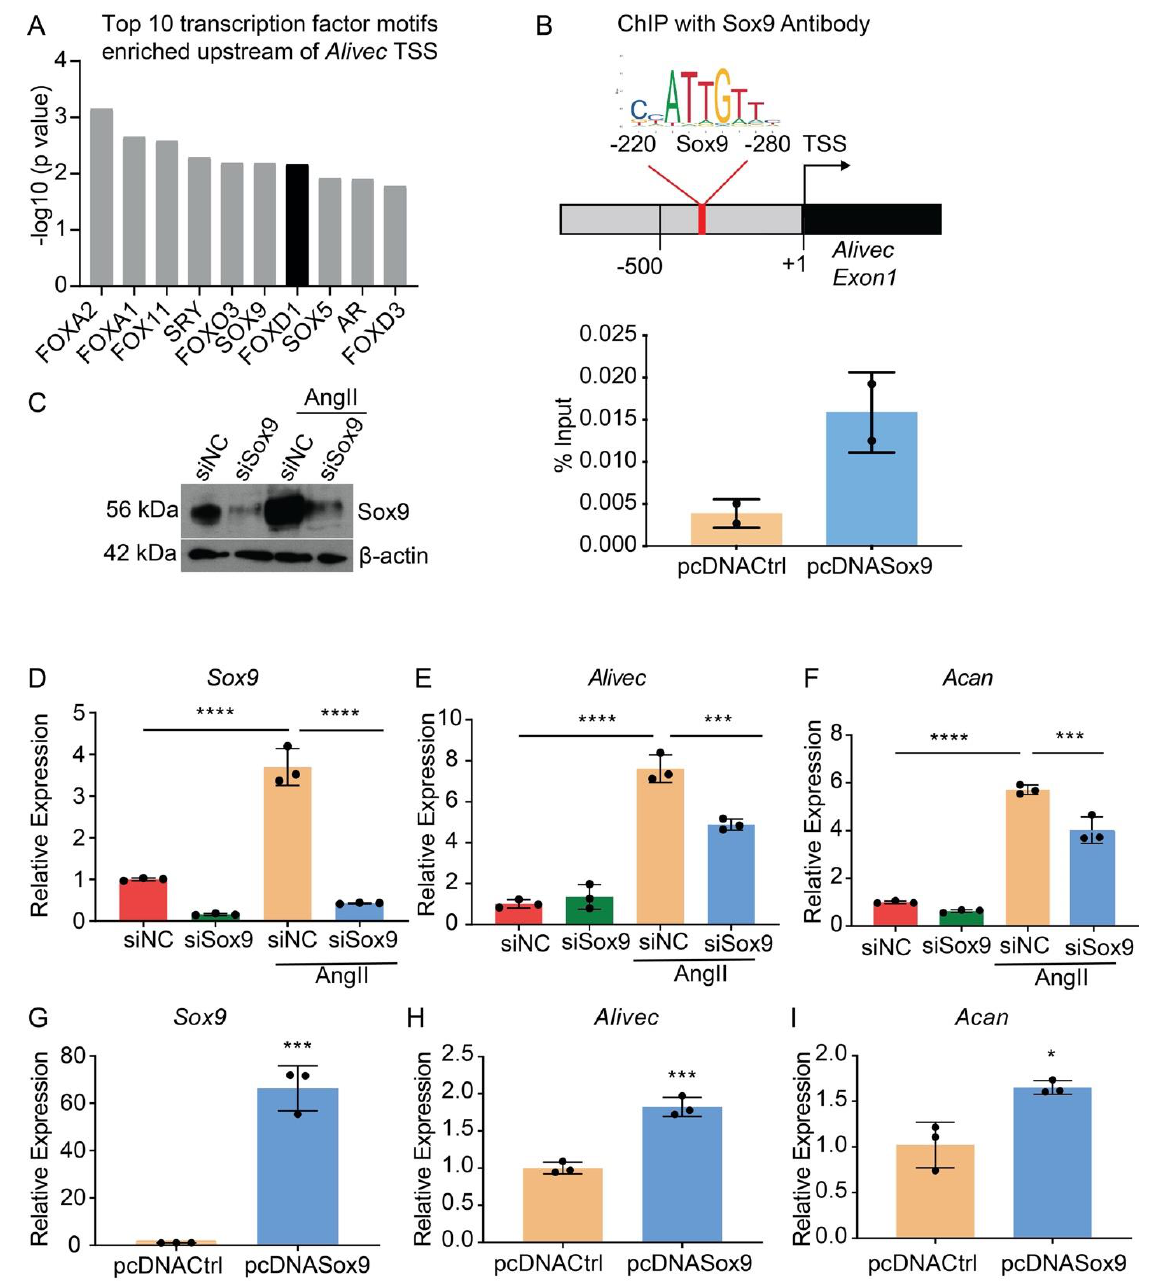
Figure 5. Transcription factor Sox9 controls Alivec expression in RVSMCs ( A ). Top 10 transcription factor (TF) binding motifs, enriched in the genomic region upstream of Alivec transcription start site (TSS). ( B ) ChIP assays with Sox9. Upper panel depicts schematic of the predicted Sox9-binding site upstream of Alivec TSS (arrow). Lower panel show ChIP-qPCR data with Sox9 antibody in RVSMCs transfected with pcDNACtrl and pcDNASox9 plasmids. ChIP-DNA was analyzed by qPCR with Alivec promoter primers overlapping Sox9-binding sites ( n = 2). ( C ) Sox9 knockdown with siRNAs. Sox9 protein levels determined by Western blotting in RVSMCs transfected with siRNA targeting Sox9 (siSox9) or negative control (siNC) oligonucleotides, and treated ± AngII (upper panel). β -actin protein levels (lower panel) were used as internal control. ( D – F ) RT-qPCR analysis of indicated genes in siSox9- and siNC-transfected RVSMCs at the basal level and after stimulation with AngII. Data presented as mean ± SD, n = 3 biological replicates, one-way ANOVA followed by Tukey’s post-hoc test and *** p < 0.001, **** p < 0.0001 vs. indicated groups. ( G – I ). RT-qPCR analysis of indicated genes in RVSMCs, transfected with Sox9 expression plasmid (pcDNASox9) and pcDNACtrl control plasmid. Data represented as mean ± SD, n = 3 biological replicates, unpaired Student’s t -test and * p < 0.05, *** p < 0.001 vs. control plasmid.